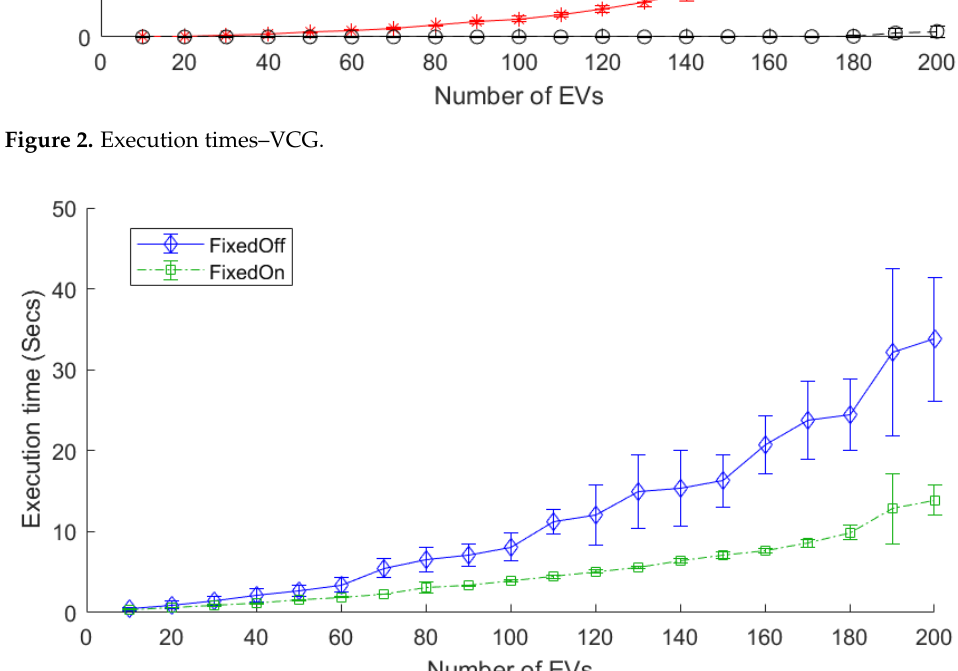
Figure 3. Execution